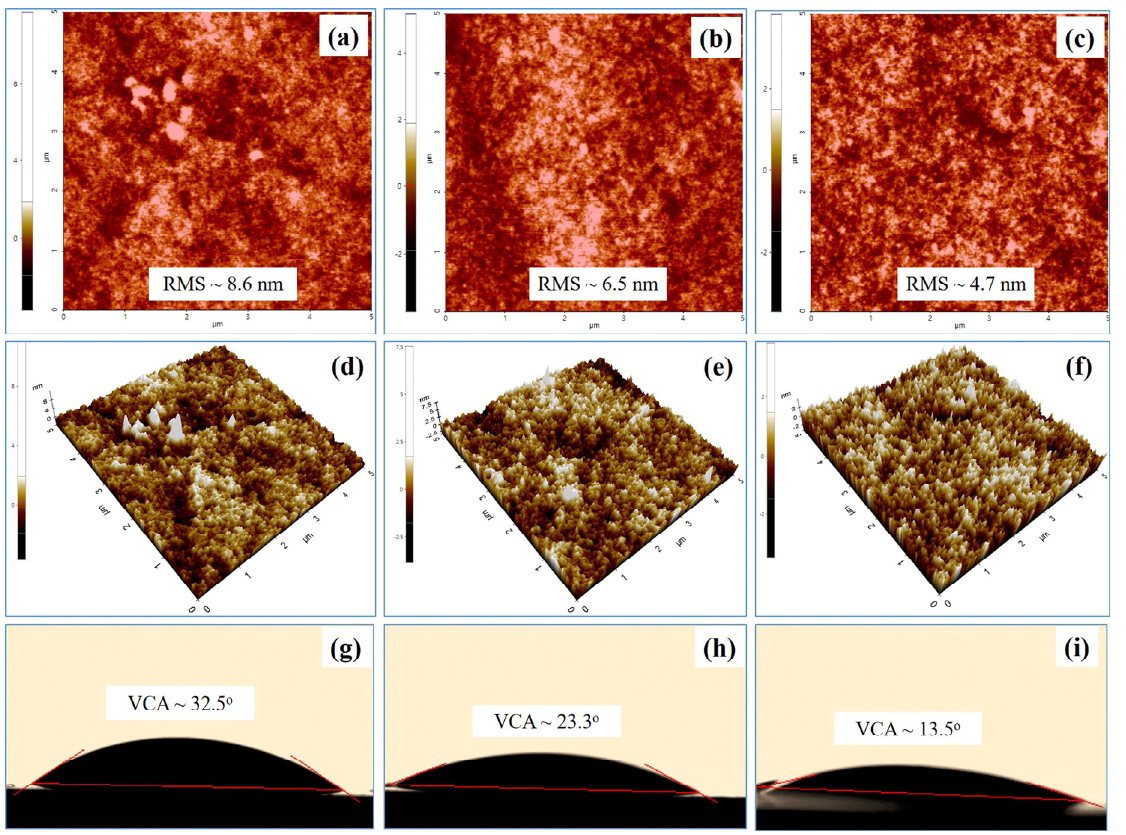
Figure 4. ( a – c ) Topography and ( d – f ) 3D AFM images of ITO/rGO/PEDOT:PSS/PbS:PCBM layer without and with the PEO buffer layer; ( g – k ) video contact angle